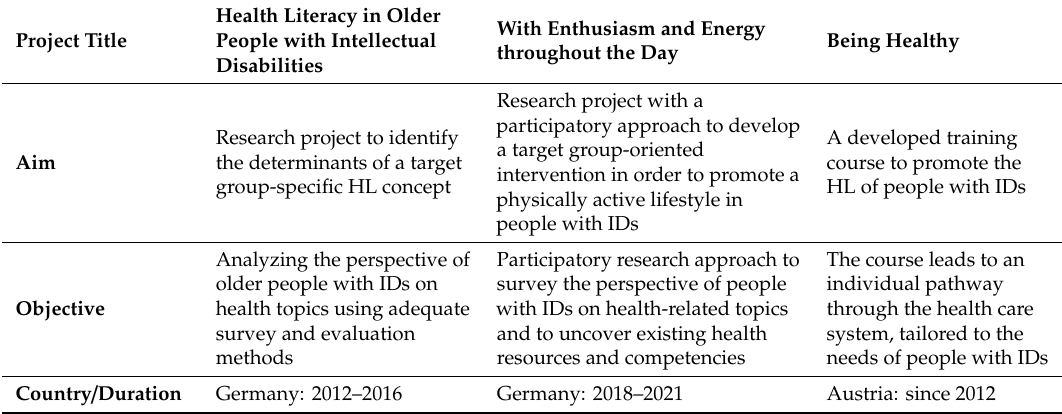
Table 1. Overview of the described